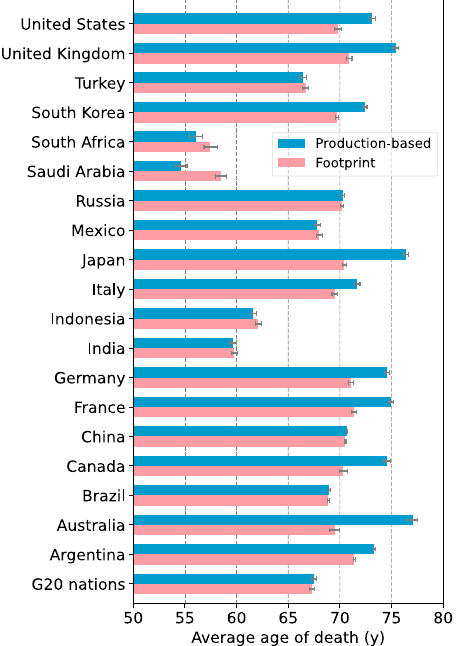
Fig. 4 G20 comparison of average age of death for PM 2.5 premature death footprint and that for premature deaths by production-based PM 2.5 emissions. Error bars indicate 95% con fi dence intervals. The centre of the bars indicates the mean